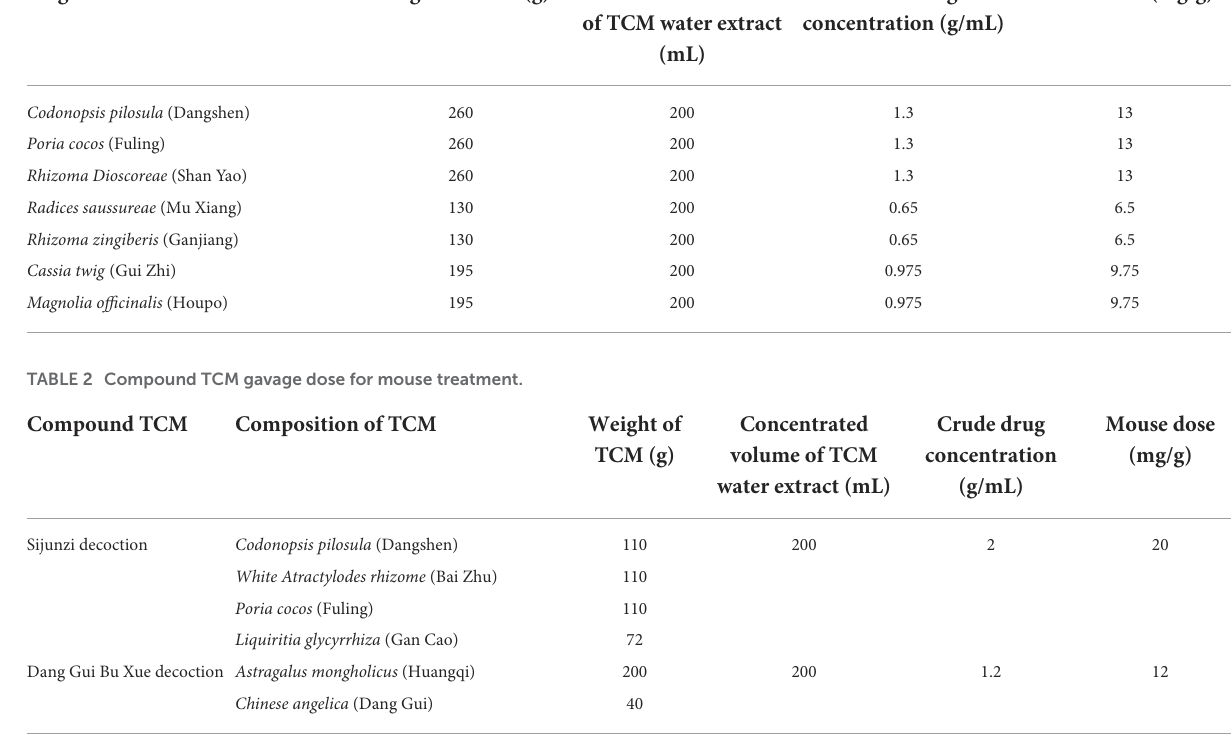
Codonopsis pilosula (Dangshen)